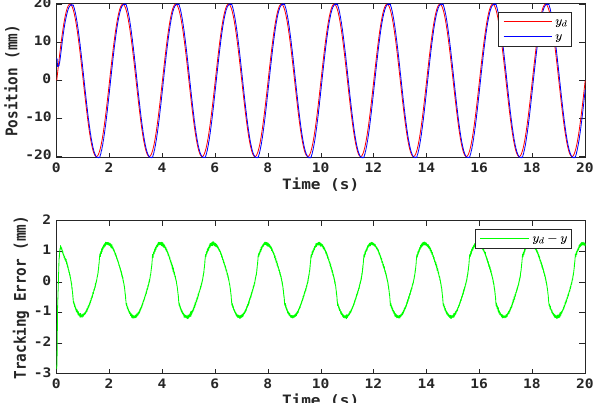
Figure 9. Tracking trajectory and tracking error of the EHS in the experiment.